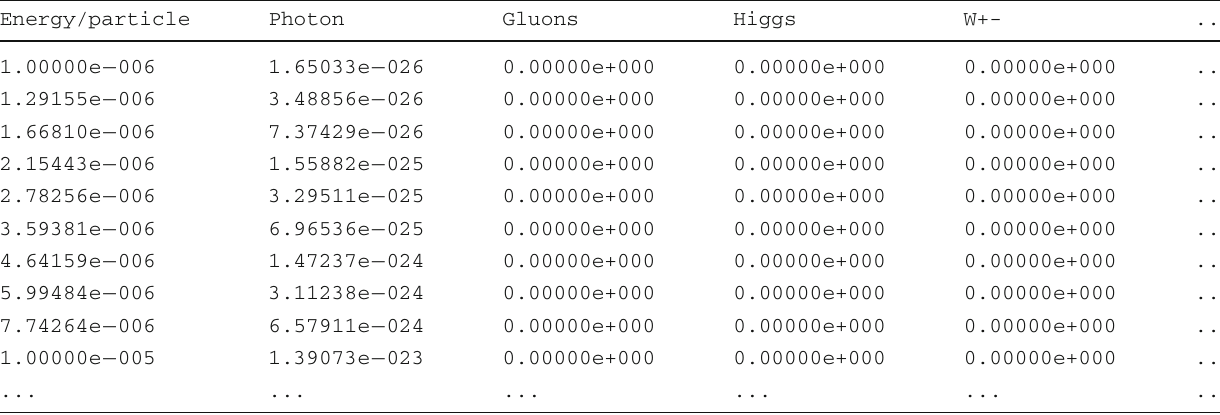
Table 8 Hawking secondary spectrum as a function of time Time/energy